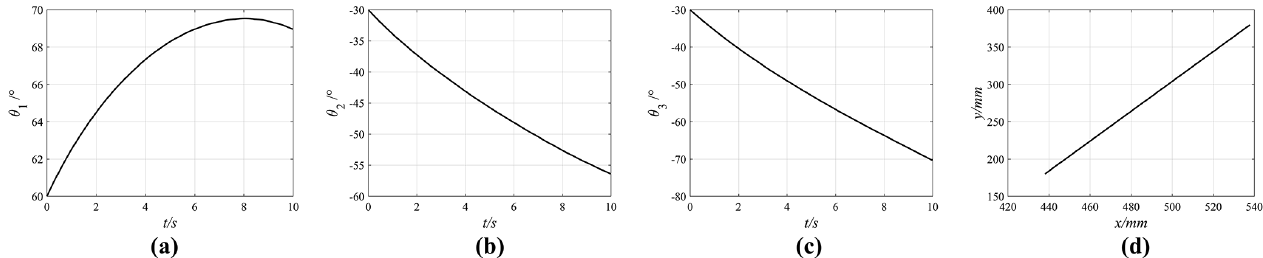
Figure 6. Motion curves of the joints and the manipulator end. (a) The first joint. (b) The second joint. (c) The third joint. (d) Trajectory of the manipulator end.